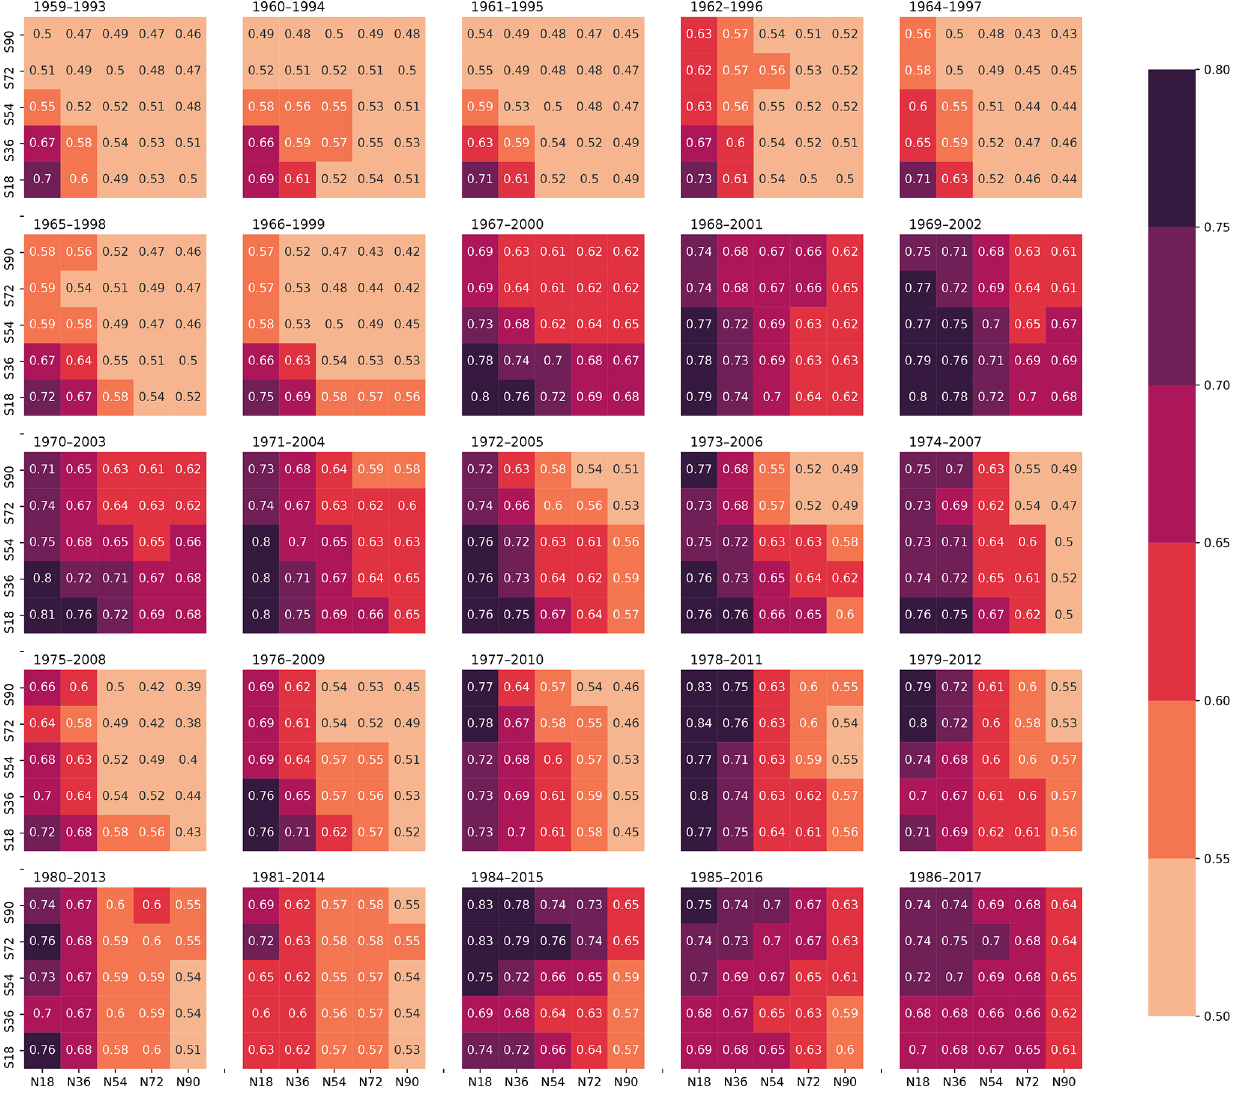
https://doi.org/10.5194/esd-13-1505-2022 Earth Syst. Dynam., 13, 1505–1533,